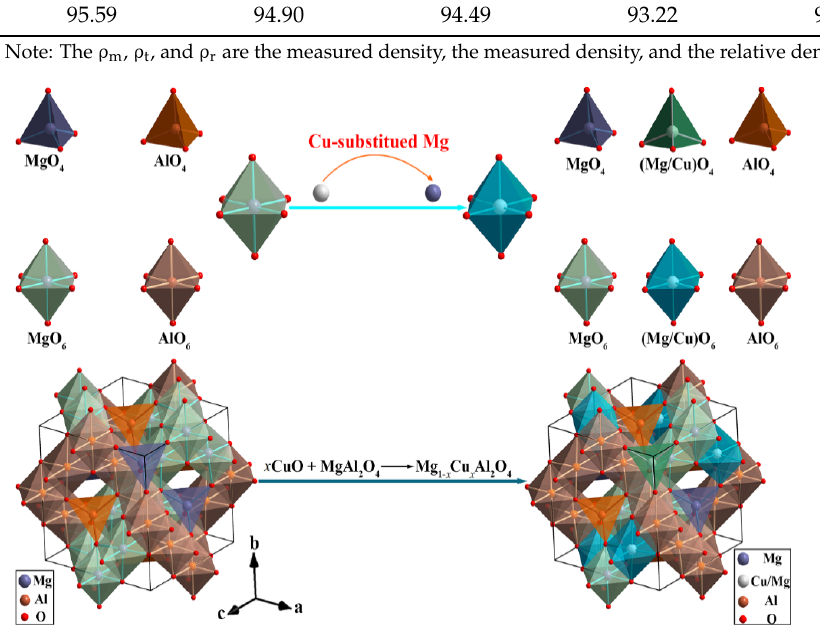
Figure 4. The schematic diagram of a crystal structure for MgAl 2 O 4 .